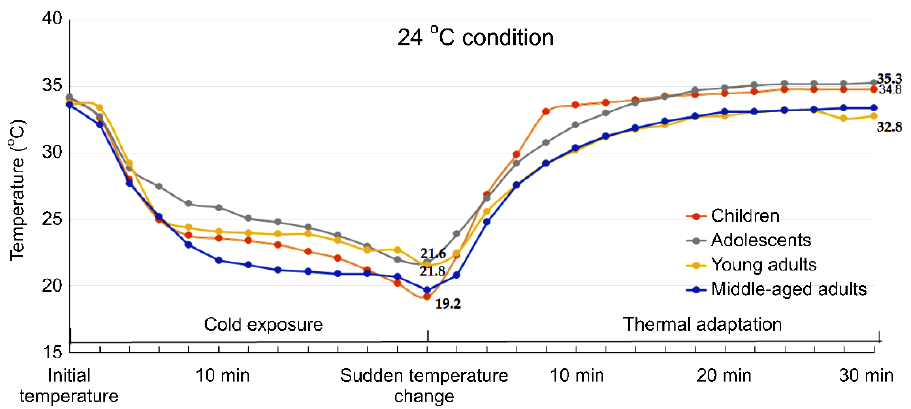
Figure 8. Comparison of forehead temperatures across different age-groups under the 24 °C con- dition.